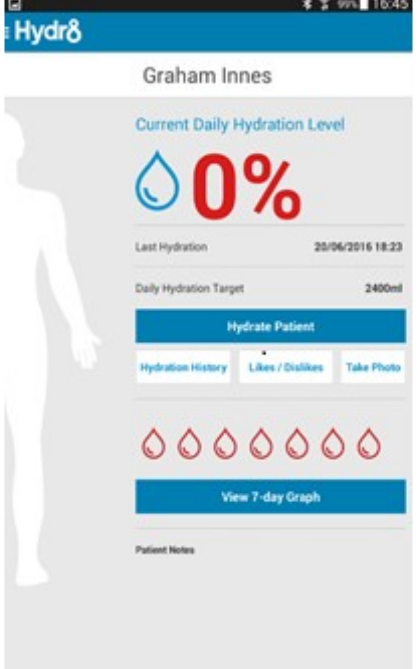
Figure 1. A screenshot from Hydr8 showing fluid intake information. Source: "Hydr8" Brochure produced by Elaros, North Tyneside Clinical Commissioning Group and the Academic Health Science Network North East and North Cumbria.